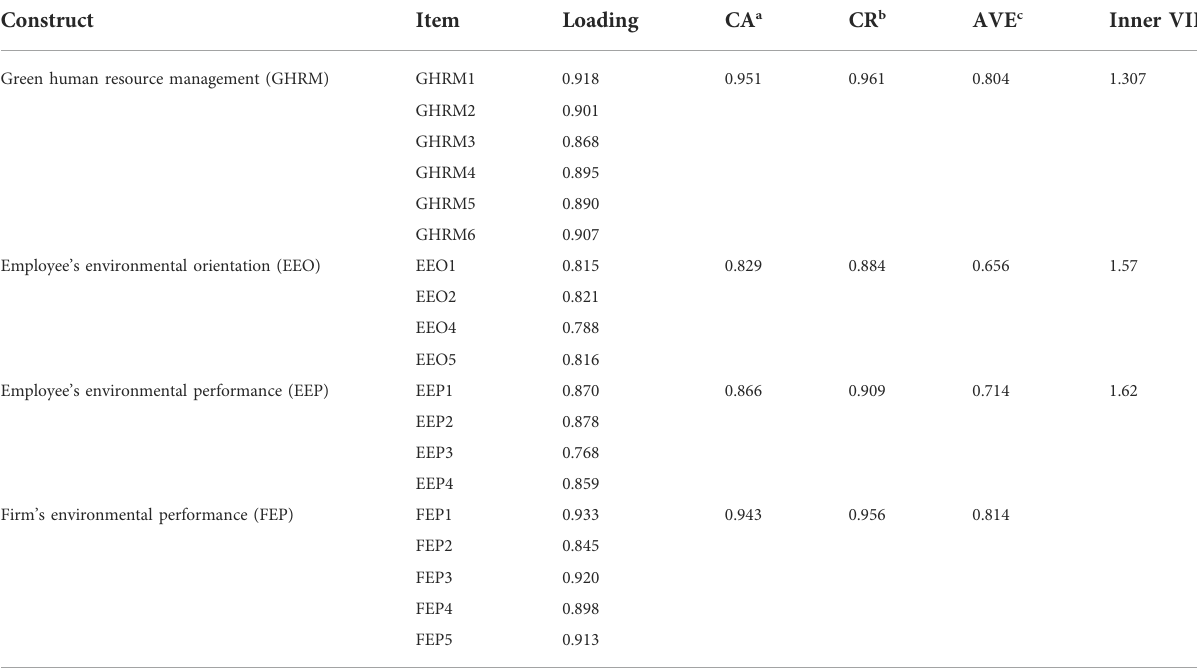
TABLE 1 Measurement model.